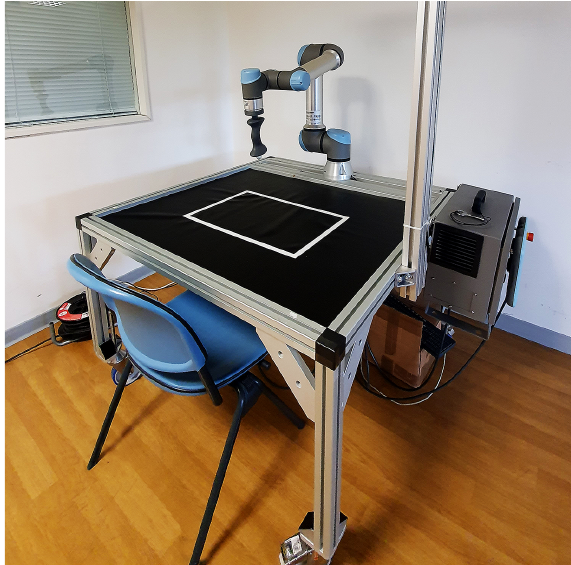
Figure 9. Final layout of the rehabilitation